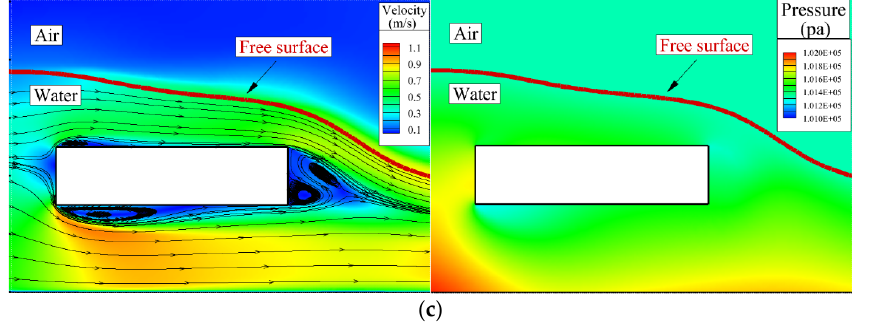
Figure 4. Velocity and pressure fields around the submerged body with the free surface interactions: ( a ) 𝐴𝑅 = 0.208, 𝑅𝑒 = 8,689.223, ( b ) 𝐴𝑅 = 2.036, 𝑅𝑒 = 12,958.475, ( c ) 𝐴𝑅 = 3.989, 𝑅𝑒 = 9,339.984. For each sample, hydrodynamic pressure coefficients (i.e., drag, lift and moment coeffi- cients) acting on submerged bodies are obtained from CFD analyses. Figure 5 shows an example of the time evolution of hydrodynamic pressure coefficients for 𝐴𝑅 = 0.208, 𝑅𝑒 = 8,689.223 (Figure 5a), 𝐴𝑅 = 2.036, 𝑅𝑒 = 12,958.475 (Figure 5b), and 𝐴𝑅 = 3.989, 𝑅𝑒 = 9,339.984 (Figure 5c). The numerical results show that the hydrodynamic force coefficients are significantly varied under the nonlinear interaction with the free surface. In the cases of lower 𝐴𝑅 values ( 𝐴𝑅 = 0.208), the force coefficients are in periodic evolutions with time and are charac- terized by a mean value and oscillated magnitude. These predicted values are determined by an averaged method over five oscillation cycles. In the case of higher values ( 𝐴𝑅 = 2.036 and 3.989), stable behaviors of the force coefficients without oscillation features are observed.